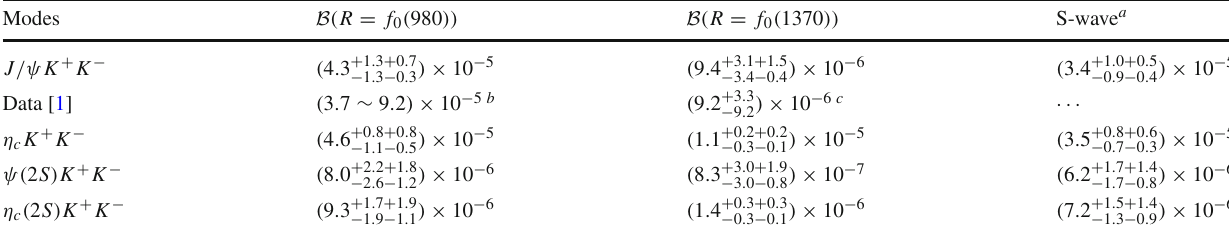
Table 2 Branching ratios of S -wave resonance contributions to the B s → ( J /ψ,ψ( 2 S ),η c ,η c ( 2 S )) K + K − decays. Theoretical errors correspond to the uncertainties of Gegenbauer moments and hard scales, respectively Modes